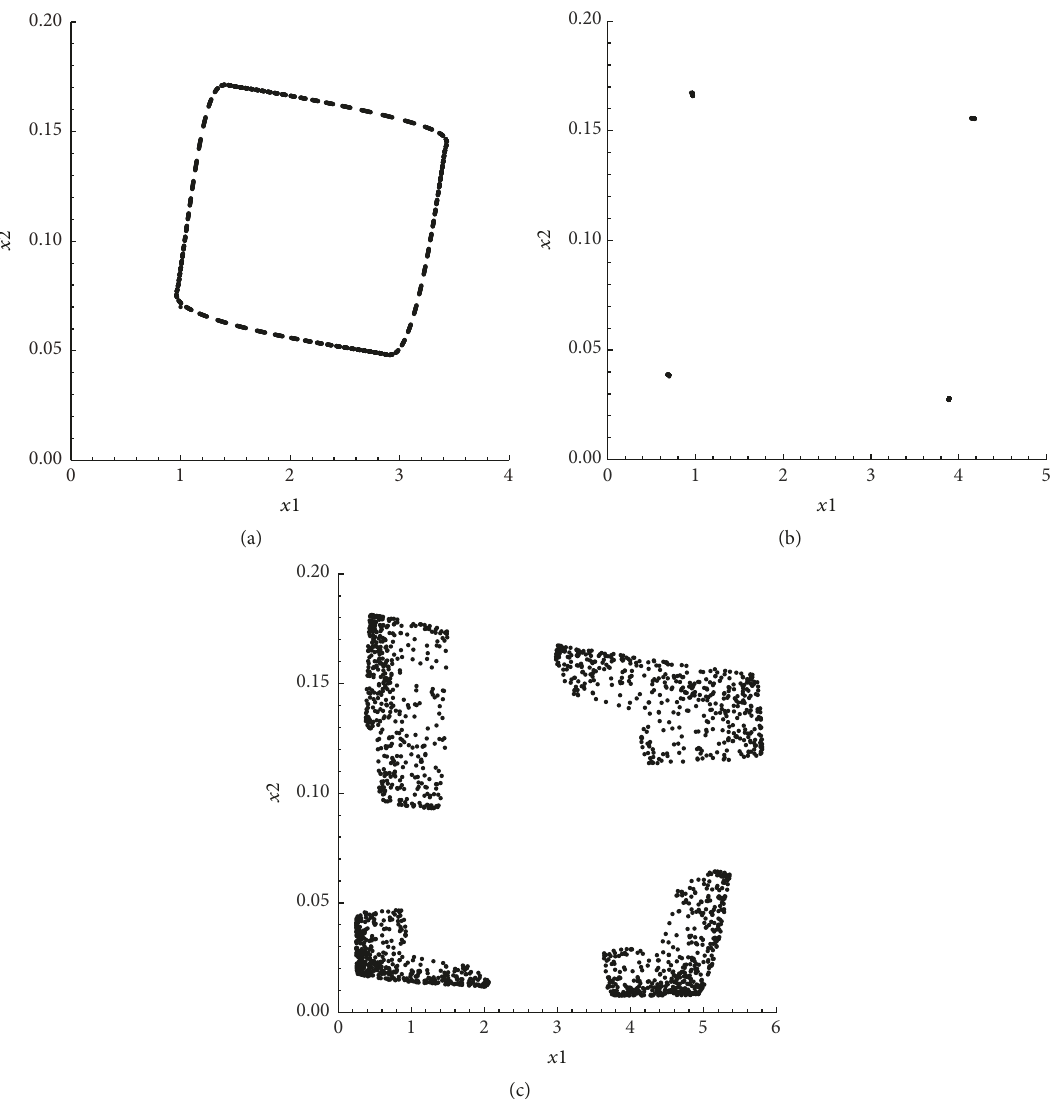
Figure 3: (a) An invariant curve. (𝛼,𝛽) = (0,1) and (𝑃,𝐹) = (0.5, 20) . (b) 4-periodic dynamics generated by map (8). (𝛼,𝛽) = (0,1) and (𝑃,𝐹) = (0.5, 25) . (c) Chaotic dynamics generated by (8). (𝛼, 𝛽) = (0, 1) and (𝑃,𝐹) = (0.5, 32)